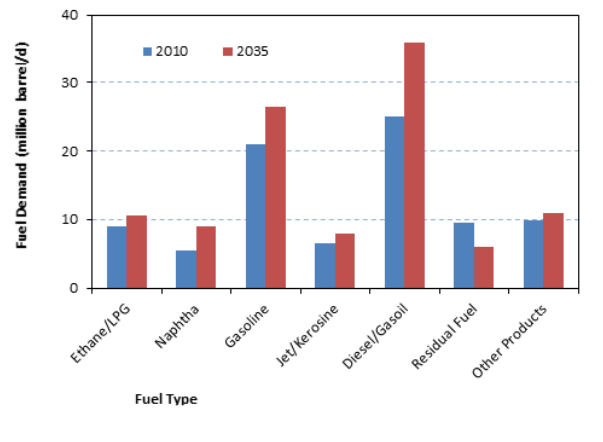
Figure 2: Projects of global fuel product demand by OPEC Source: OPEC (2011) Strategic options for GTL